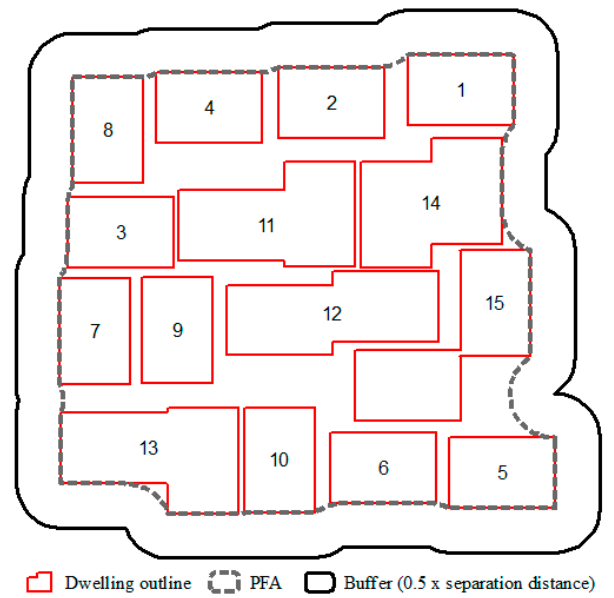
Figure 16. Example settlement, demonstrating the construction of the potential fire area (PFA). Dwellings are buffered outwards by 0.5 × the separation distance. The resulting polygon is then buffered back by the same distance to obtain the PFA aligning with the walls of the outermost dwellings. Numbers in each dwelling correspond to the ID in Table 2.